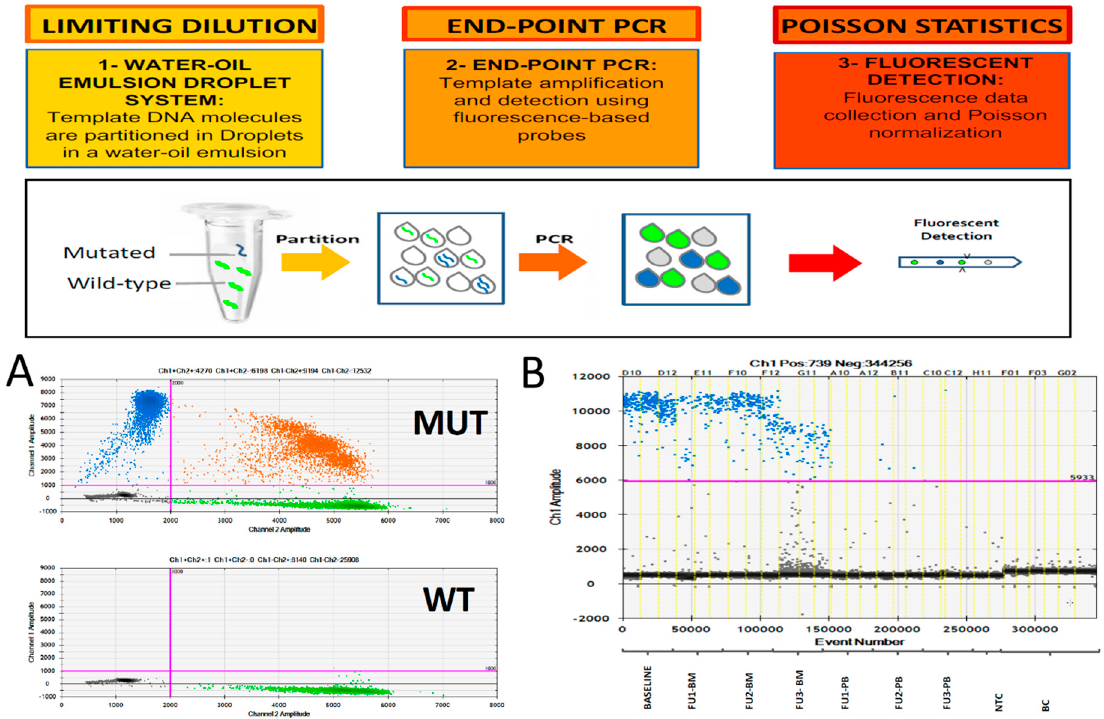
Figure 1. Droplet digital PCR key steps and workflow. ( A ) example of mutation detection assay; ( B ) example of immunoglobulin heavy chain minimal residual disease (IGH-MRD) monitoring (Baseline: diagnosis, FU: follow-up; BM: bone marrow; PB: peripheral blood, NTC: no template control, BC: buffy coat).